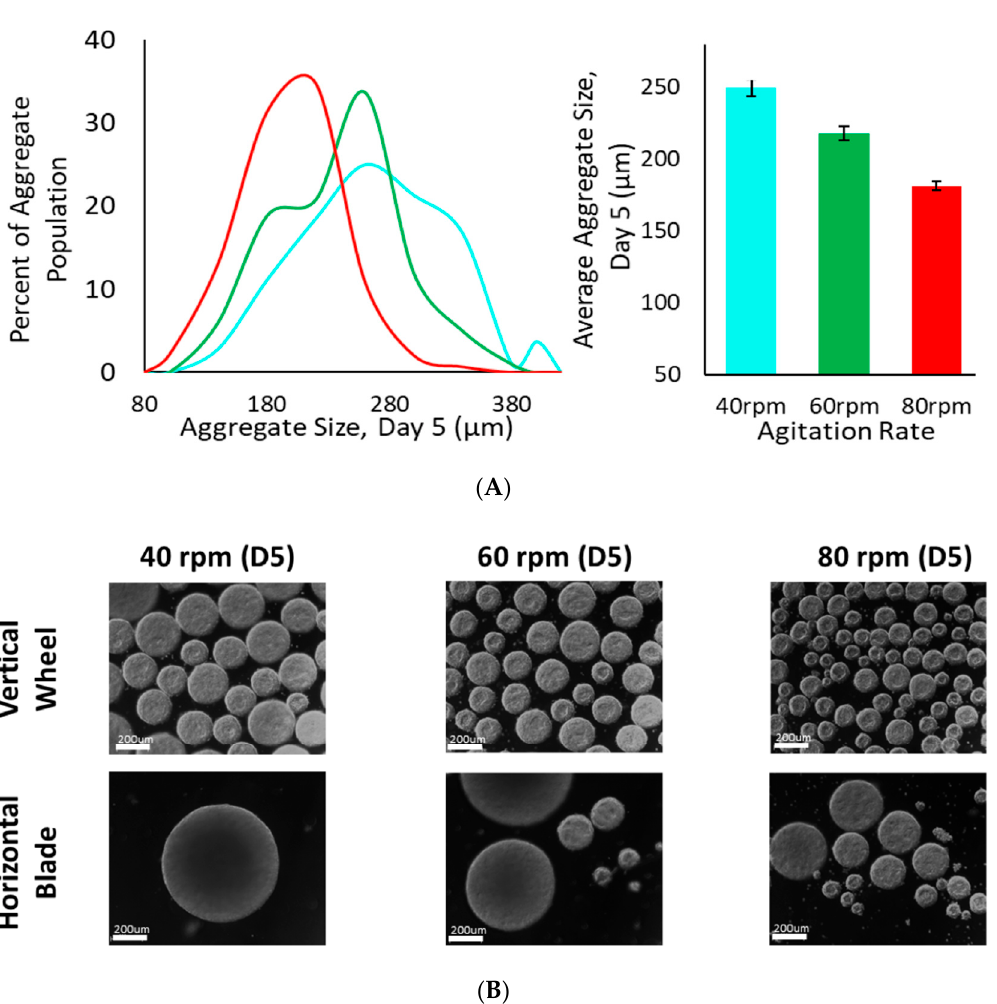
Figure 3. ( A ) Inverse correlation between average iPSC aggregate diameter and agitation rates in Vertical-Wheel bioreactor (0.1 L Scale). ( B ) Comparison of iPSC aggregate diameters and morphology with different agitation rates in Vertical-Wheel bioreactor vs. horizontal-blade spinner (0.1 L scale). Scale bar (200 μ m).